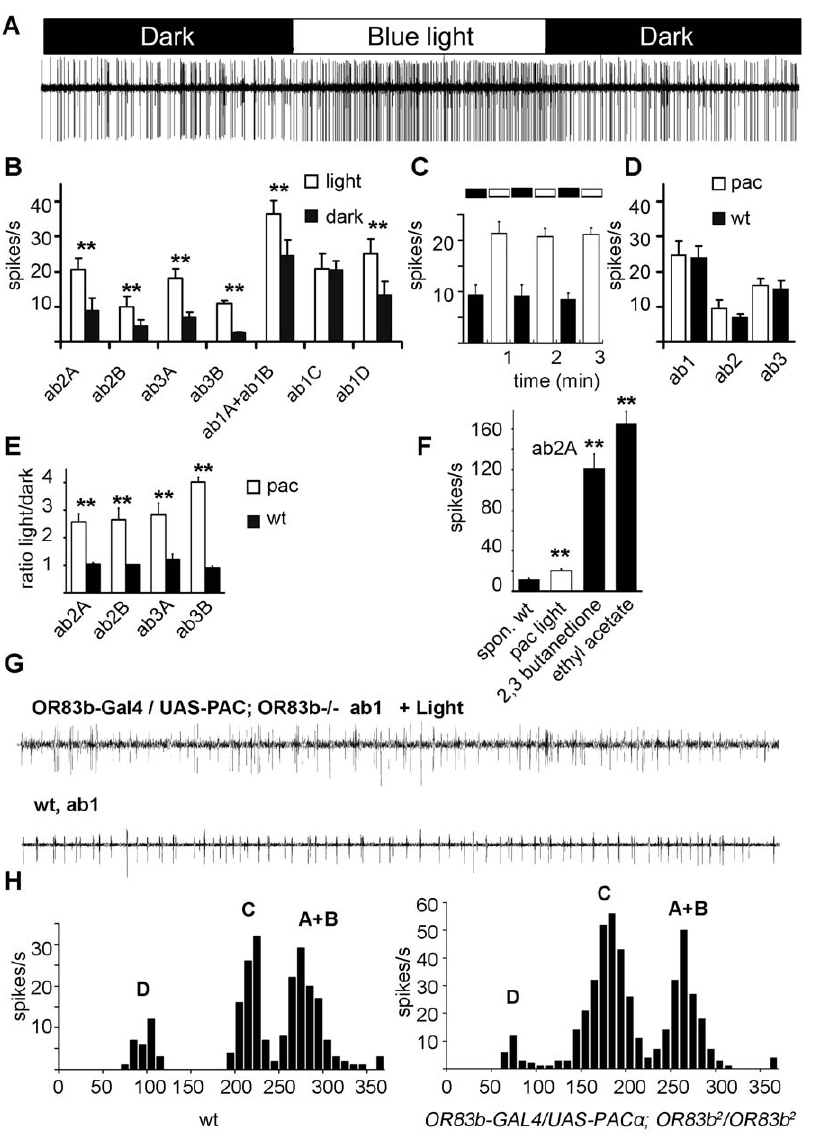
Figure 6. Increased cAMP levels can recover the spontaneous activity of olfactory neurons. ( A ) Increase in spike rates in single unit recordings from the ab2 sensillum in Or83b-Gal4; UAS-Pac a flies upon transition from dark to strong blue light excitation showing that cAMP increase stimulates an excitatory pathway in olfactory neurons, the increase was rapidly reversible. ( B ) Summaries of single unit recordings from the different neurons in the ab1, ab2 and ab3 sensilla. ( C ) Reversibility of the response to light shown by repeated 30 s on/off cycles in ab2A neurons. ( D ) Summaries of single unit recordings from ab1, ab2 and ab3 sensilla from wt (white bars) and Or83b-Gal4; UAS-Pac a flies (black bars) recorded in the dark. ( E ) Ratios of spike rates for ab2A, ab2B, ab3A and ab3B neurons recorded under blue light illumination vs. dark, showing the relative increases in spike rates in wt (black bars) and Or83b-Gal4; UAS-Pac a flies (white bars). ( F ) Comparison of the light induced spike rate in the ab2A neuron in Or83b- Gal4; UAS-Pac a flies (white bar) to spontaneous and odor induced spike rates in wt (black bars) flies. ( G ) Single unit recording of wt ab1 sensillum and of the blue light illuminated Or83b-Gal4/UAS-PAC a ; Or83b 2 /Or83b 2 ab1 sensillum. ( H ) Analysis of the of spike amplitude distribution recorded from ab1 sensilla in wt and Or83b-Gal4/UAS-PAC a ; Or83b 2 /Or83b 2 flies. Data shown represent about 450 spikes form 8 s recording. ‘‘A’’–‘‘D’’ indicate subpopulations of spikes attributed to neurons A, B, C and D. Differences between the indicated data points were statistically checked by the unpaired Student’s t test, *p , 0.05; **p , 0.01. Error bars represent